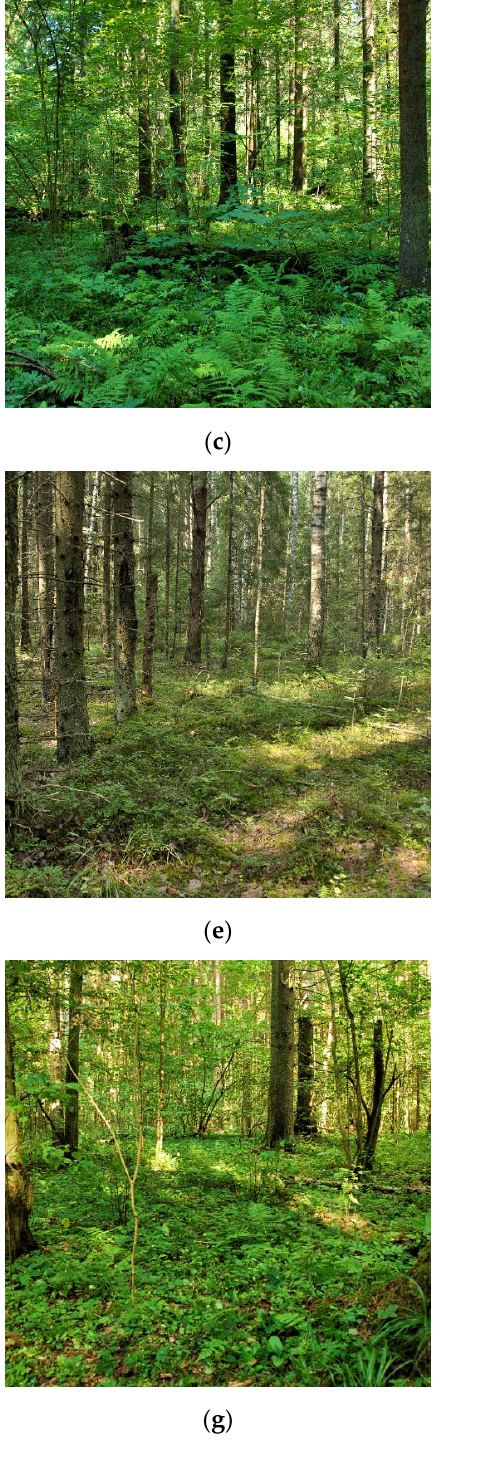
Figure 5. Photographs of plant communities: ( a ) spruce with birch and pine DShG (photo by O. Morozova); ( b ) spruce with birch and pine Sh (photo by O. Morozova); ( c ) spruce with birch ShBh (photo by O. Morozova); ( d ) spruce with birch, lime and oak Bh; ( e ) spruce–aspen / birch with pine DShG (photo by O. Morozova); ( f ) spruce–aspen / birch Sh (photo by N. Belyaeva); ( g ) spruce–aspen / birch ShBh (photo by O. Morozova); and ( h ) spruce–aspen / birch with lime and oak Bh (photo by T. Chernenkova).